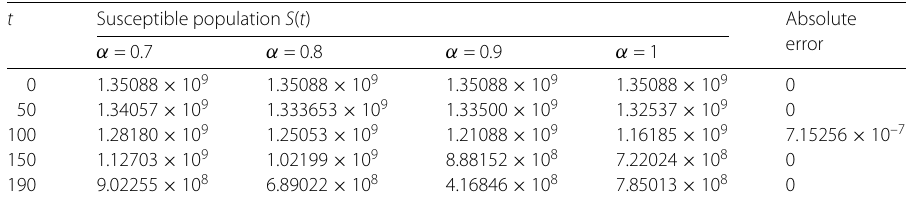
Table 2 Numerical results of susceptible population S ( t ) for fractional parameter τ = 0.7,0.8,0.9,1 and comparison between classical and approximate